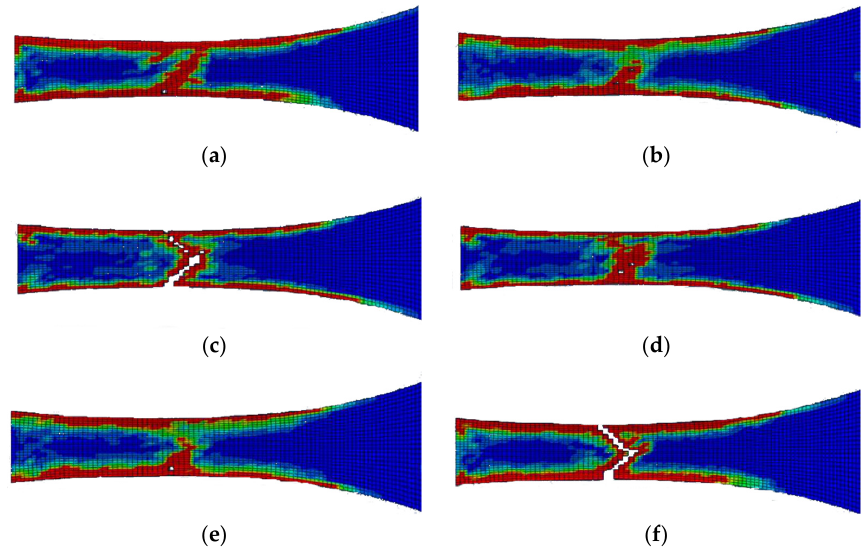
Figure 15. Damage evolution of each top composite layer of specimen C at 1 mm displacement.